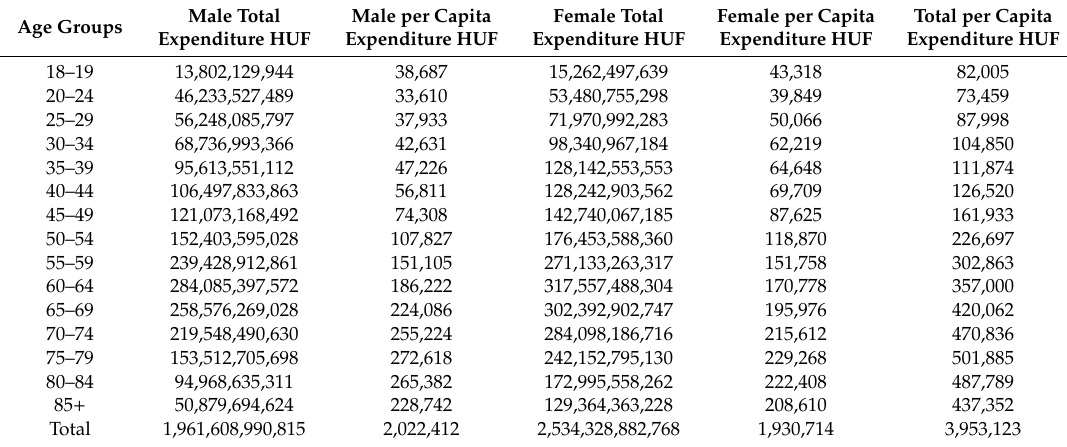
Table A3. Age and sex specific per capita expenditures of National Health Insurance Fund a year for the period of 2012–2016 in